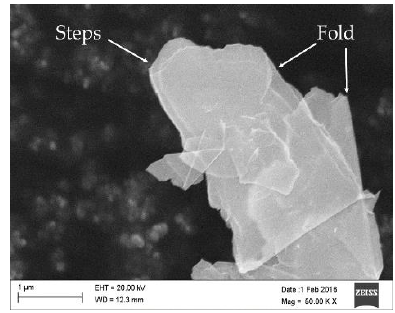
Figure 7. Cryogenically milled G-PA66 20 min showing transparency of exfoliated graphene flake, at high magnification.